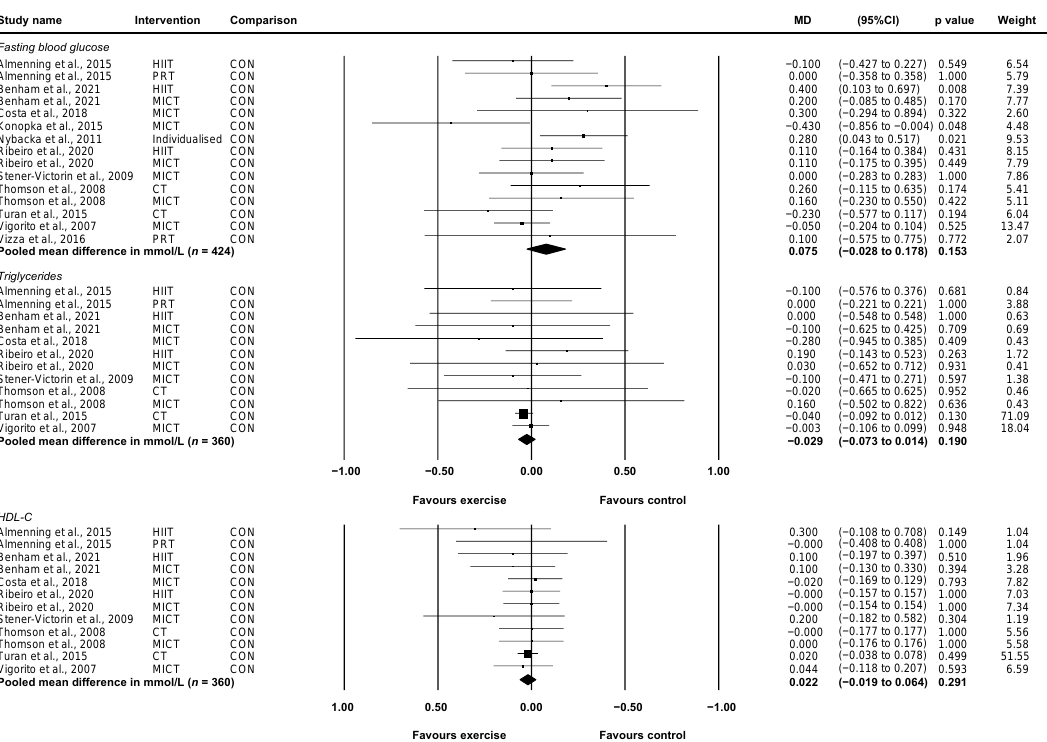
Figure 6. Effect of exercise vs. control for change in fasting blood glucose, HDL-C, and triglycerides. CI: confidence interval, CT: concurrent training, HDL-C: high-density lipoprotein cholesterol, HIIT: high-intensity interval training, MD: mean difference, MICT: moderate-intensity continuous training, PRT: progressive resistance